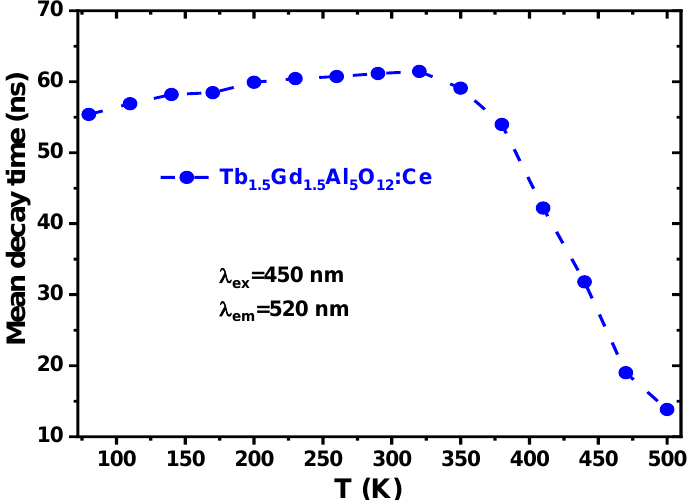
Figure 6. Temperature dependence of the photoluminescent mean decay times of Ce 3+ emission at 520 nm under excitation into 4f → 5d 1 absorption band of Ce 3+ at 450 nm.